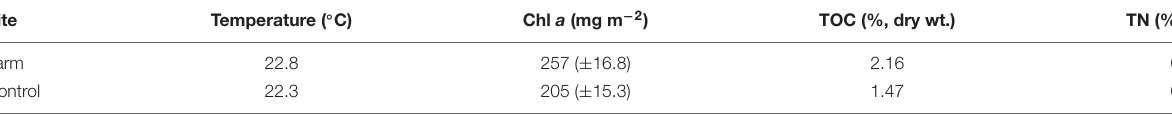
TABLE 3 | Environmental parameters in the surface sediment (0–2 cm) of the fish farm and control sites. Site